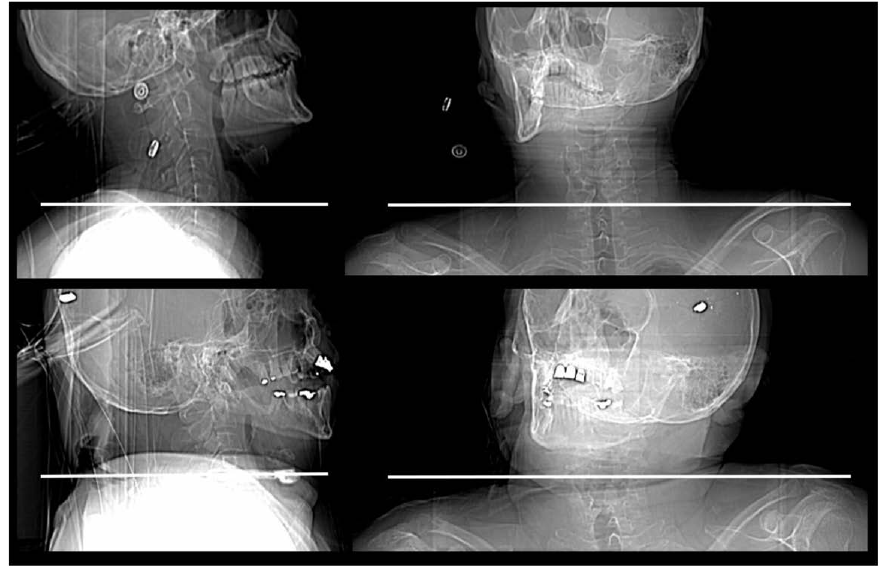
Figure 2. Lateral and anteroposterior topograms are presented and shoulder position are indicated in the same cadavers presented in Figures 1 and 3. The upper topograms belong to patients of Figure 1 and the lower ones to the patient of Figure